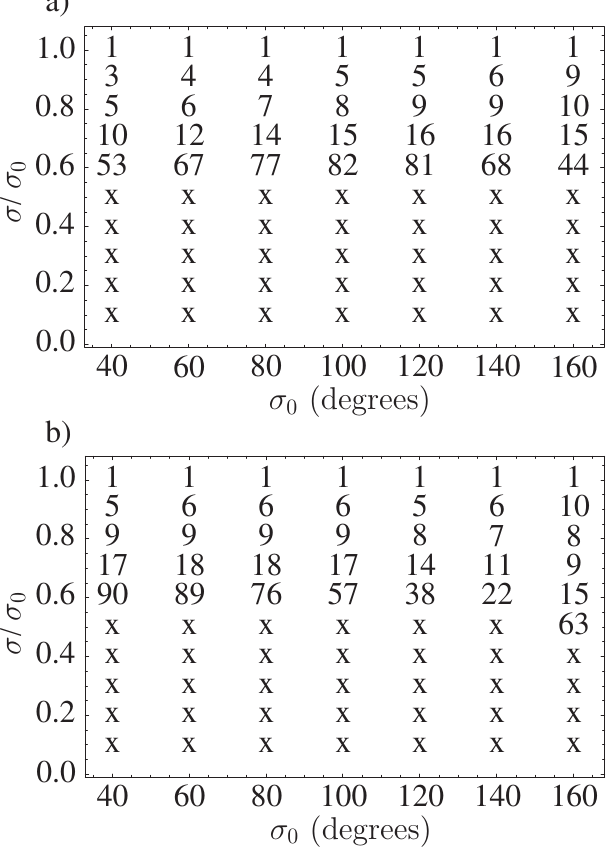
FIG. 6. Number of conventional IM iterations needed in case 0 to achieve a tol (cid:2) 10 (cid:1) 6 fractional error tolerance matched envelope solution for (a) solenoidal and (b) FODO ( (cid:7) (cid:2) 1 = 2 ) (cid:2) 40 (cid:10) , 60 (cid:10) , 80 (cid:10) , (for (cid:6) quadrupole lattices as a function of (cid:6) 0 0 (cid:2) 0 : 1 , 0 : 2 , 0 : 3 , . . . , 1 : 0 ). System (for (cid:6)=(cid:6) . . . , 160 (cid:10) ) and (cid:6)=(cid:6) 0 0 (cid:2) 0 : 5 m , (cid:9) (cid:2) 0 : 5 , and " (cid:2) 50 mm mrad . parameters are: L p Parameters where the method fails are marked